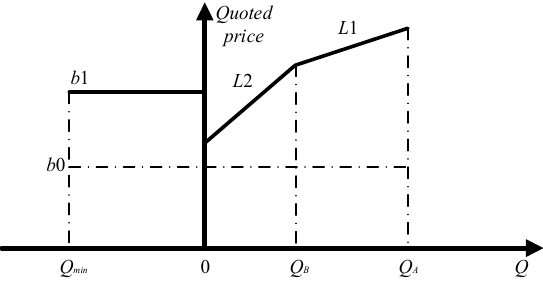
Figure 3. Reactive power quotation curve of the synchronous condenser.